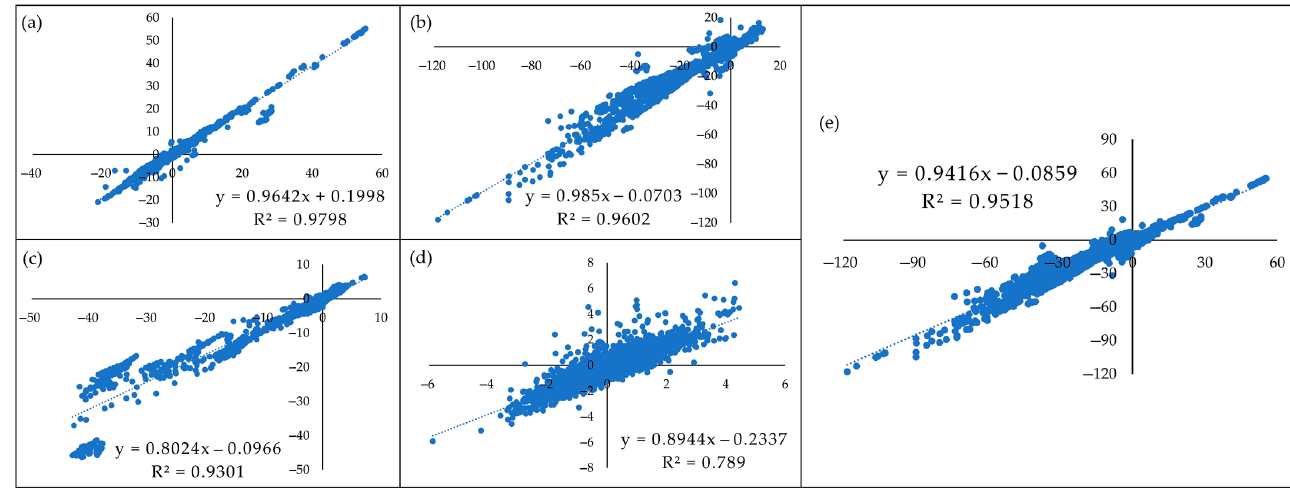
Figure 10. LRR change for the original and forecasted 2020 shoreline, ( a ) Sinaloa, ( b ) Sonora, ( c ) Baja California, ( d ) Baja California Sur, and ( e ) GC.